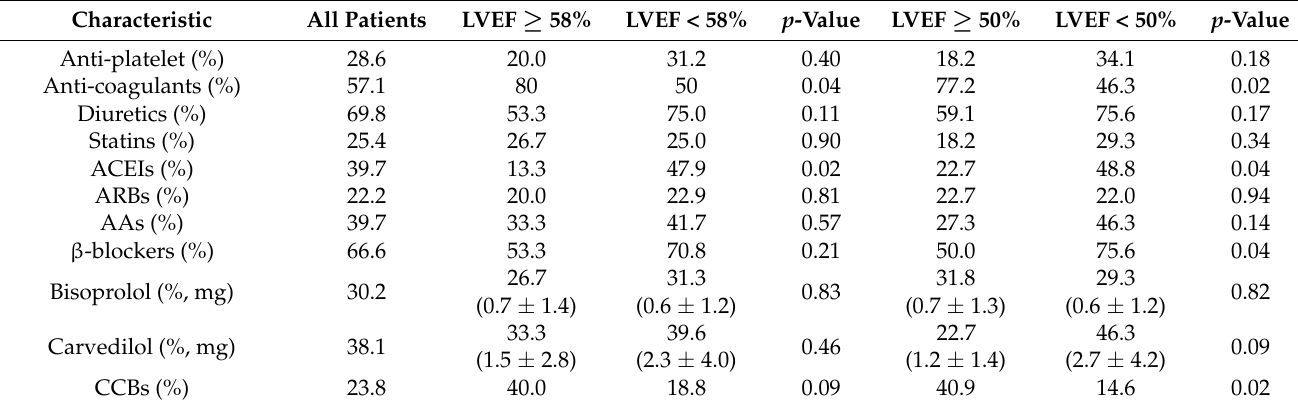
Table 3. Comparisons of medication.